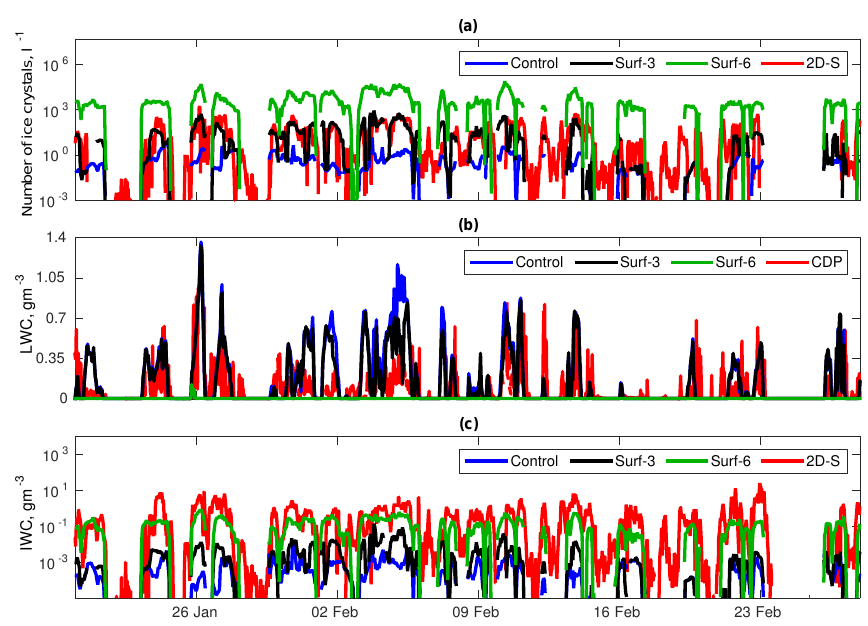
Figure 12. (a) Comparison of measured 2D-S ice number concentration at Jungfraujoch during the INUPIAQ campaign with the concentra- tion from the control WRF model simulation, and the Surf-3 and Surf-6 simulations which included the addition of crystals from a surface flux calculated using Eq. (6). (b) Comparison of measured LWC at Jungfraujoch during the INUPIAQ Campaign with the LWC from the control WRF model simulation, and the Surf-3 and Surf-6 simulations, which included the addition of crystals from a surface flux. (c) Com- parison of IWC inferred from 2D-S measurements at Jungfraujoch during the INUPIAQ campaign with the IWC from the control, Surf-3 and Surf-6 WRF model simulations.